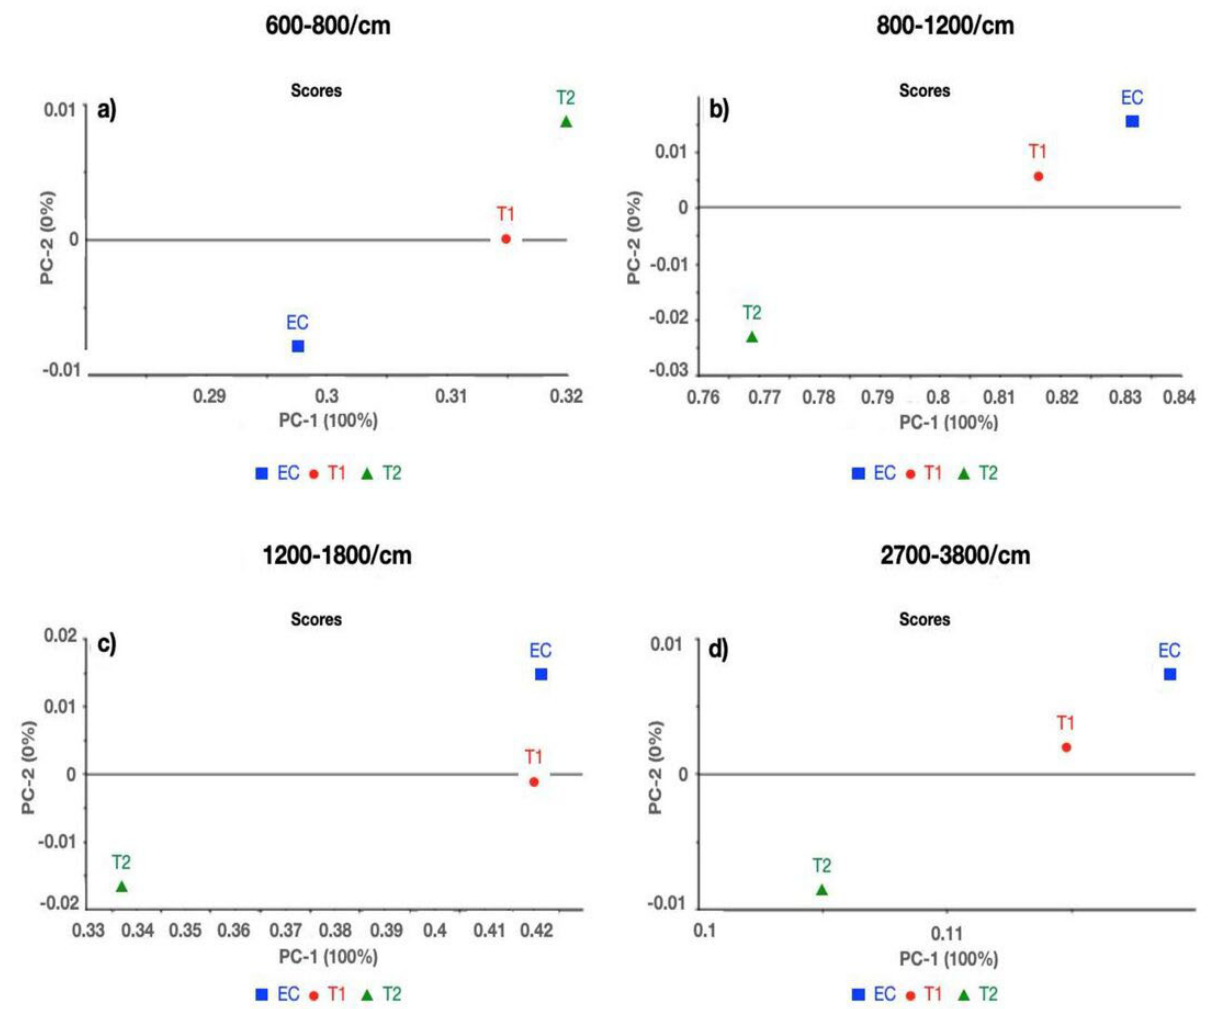
Figure 1. Principal component analysis (PCA) of EQUIA coat (E), 1% TiO 2 (ET1), and 2% TiO 2 (ET2) at spectral ranges ( a ) 600–800/cm, ( b ) 800–1200/cm, ( c ) 1200–1800/cm, and ( d ) 2700–3800/cm.